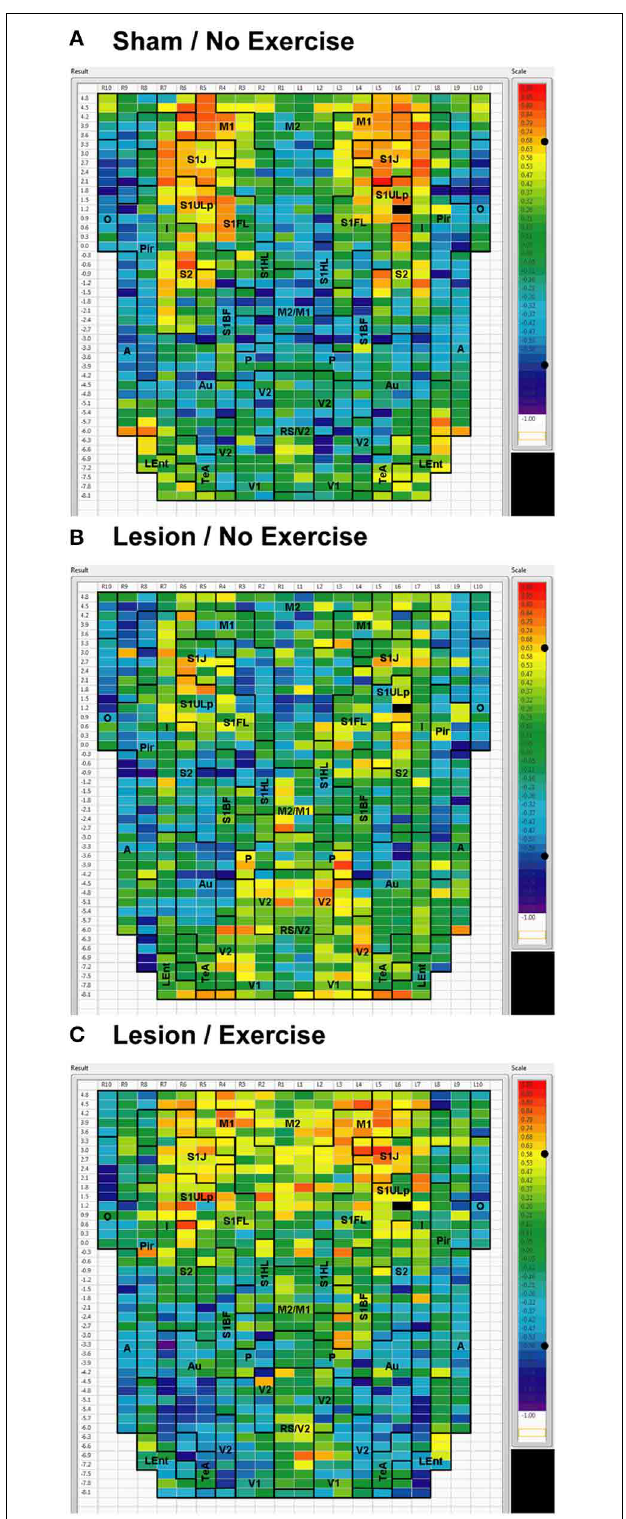
FIGURE 5 | Cortical functional connectivity of the S1ULp seed. Shown are animals receiving (A) sham treatment, (B) lesion without exercise, and (C) lesion with exercise. The seed is placed in the left anterior part of the